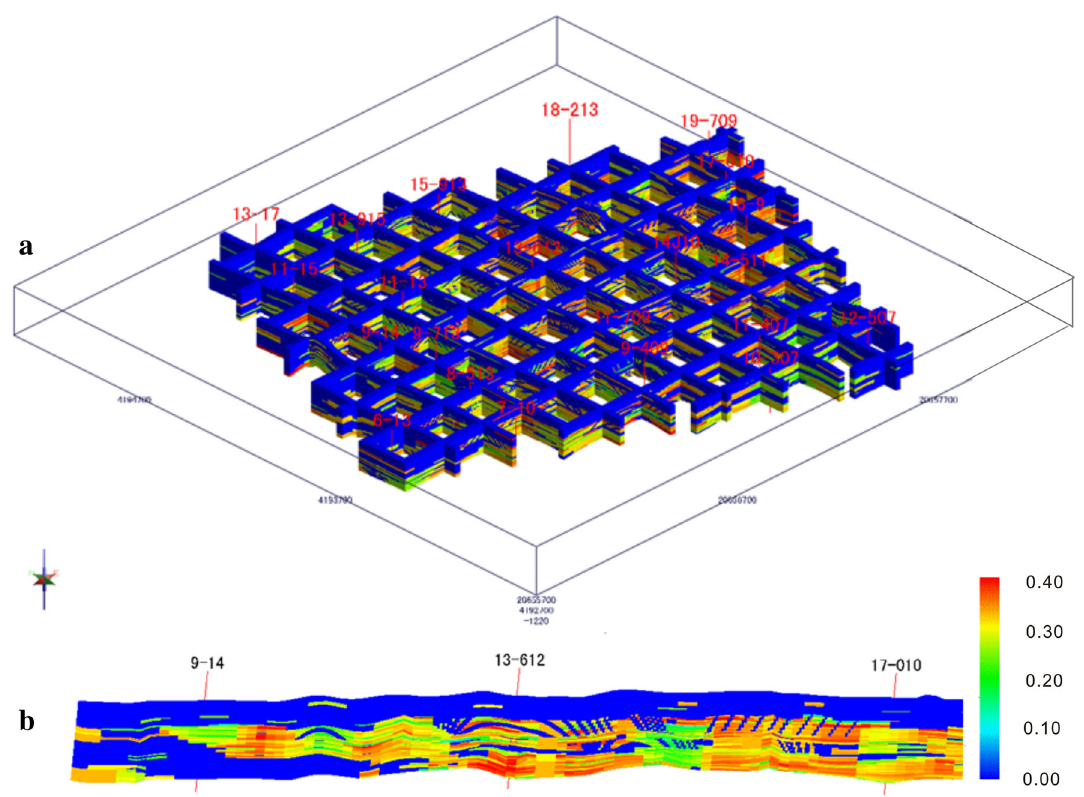
Fig. 12 a Three-dimensional grid chart of porosity model constraint by architecture model in Ng33 thin layer. b Section map of porosity model in Ng33 thin